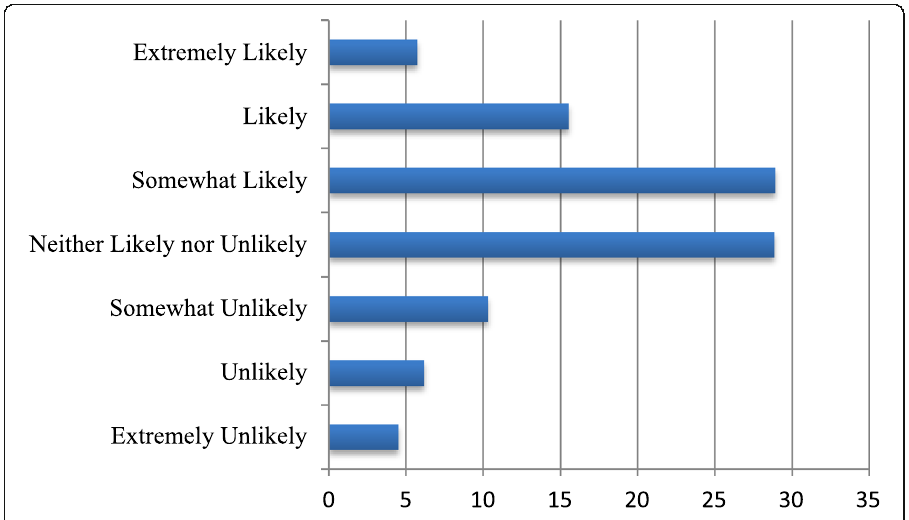
Fig. 8 Intention to purchase ratings: ‘ alternative protein source ’ (%; pooled all countries )